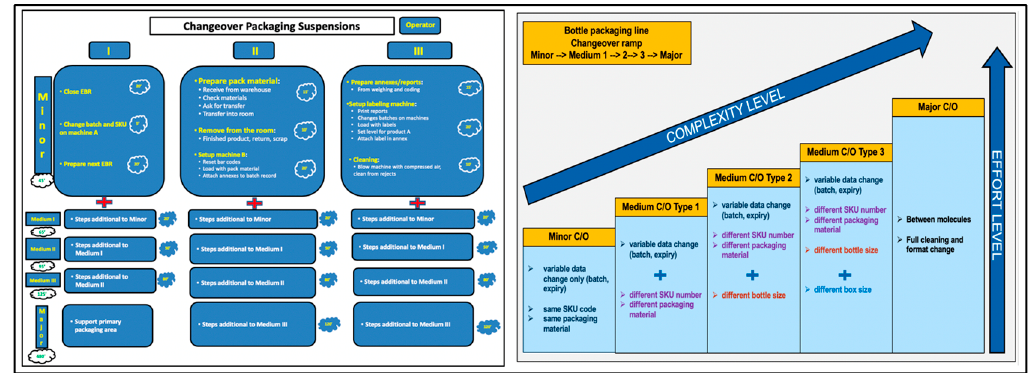
Figure 2. Changeover scheme ( left ) and Changeover ramp ( right ). Legend: SKU (Stock Keeping Unit); C/O (Changeover).